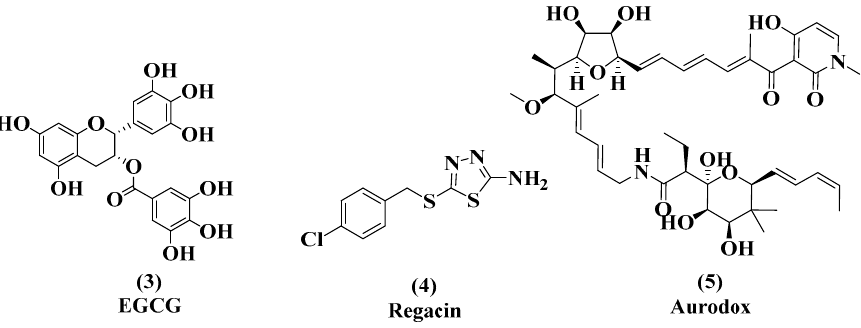
Figure 3. Structures of epigallocatechin-3-gallate (EGCG, ( 3 ), regacin ( 4 ), and aurodox ( 5 )).